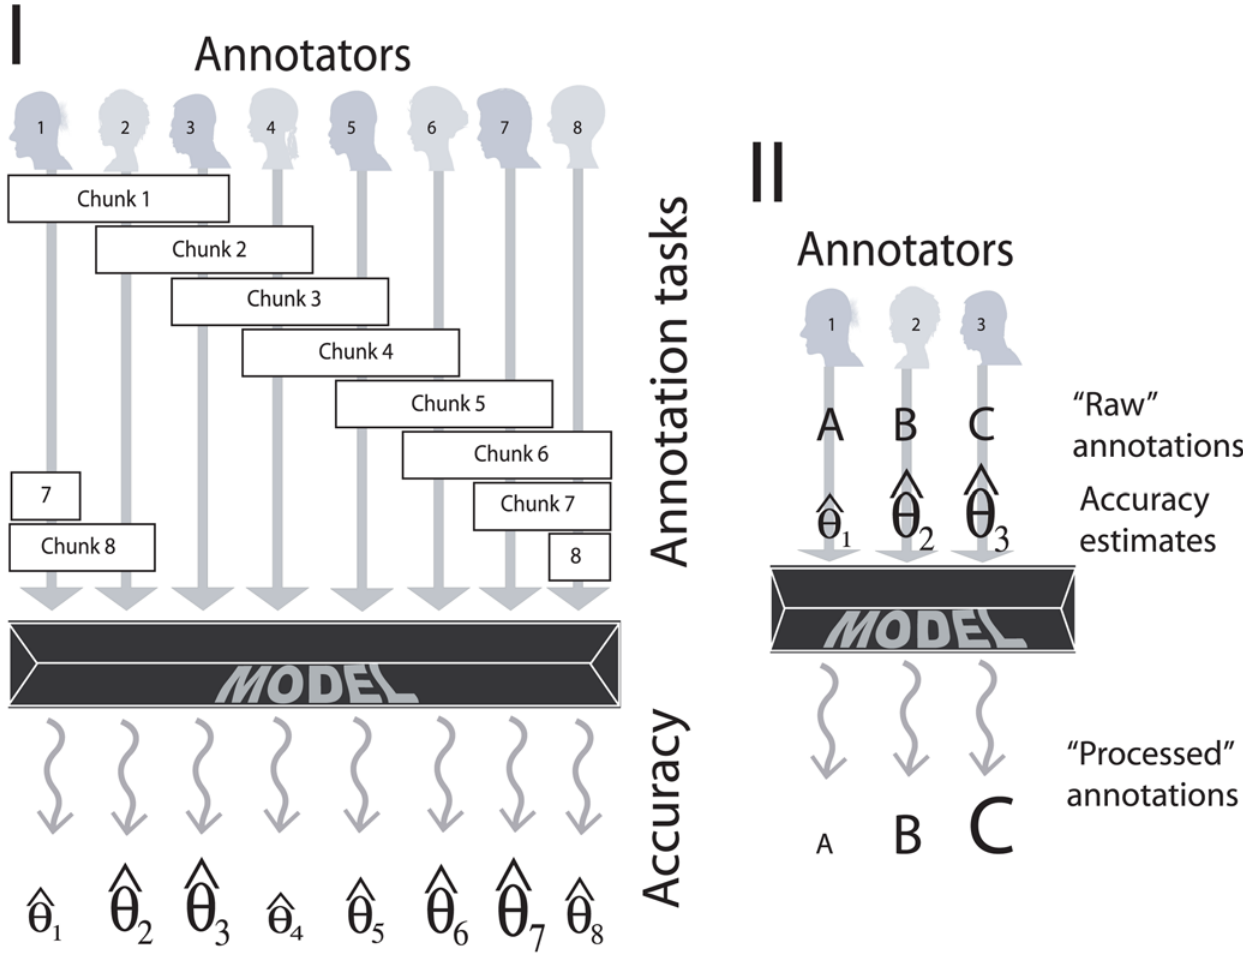
Figure 1. Two stages of our analysis: annotation (I) and inference (II). First, we used a loop design of experiments to generate annotation data and to estimate the annotator-specific correctness parameters (I). Second, we used the correctness parameter estimates obtained to resolve annotation conflicts and estimate the posterior probability associated with each alternative annotation (II). The probabilistic model is depicted as a dark prism. We had eight annotators grouped into three-annotator groups in such a way that each annotator participated in exactly three groups and all groups were different. This ensured that we could recover correctness estimates for all eight annotators even though some of them (for example, annotators 2 and 7) never annotated the same fragment of text. (Size of symbols representing hypothetical correctness parameter estimates is intended to indicate the magnitude of the corresponding value.)